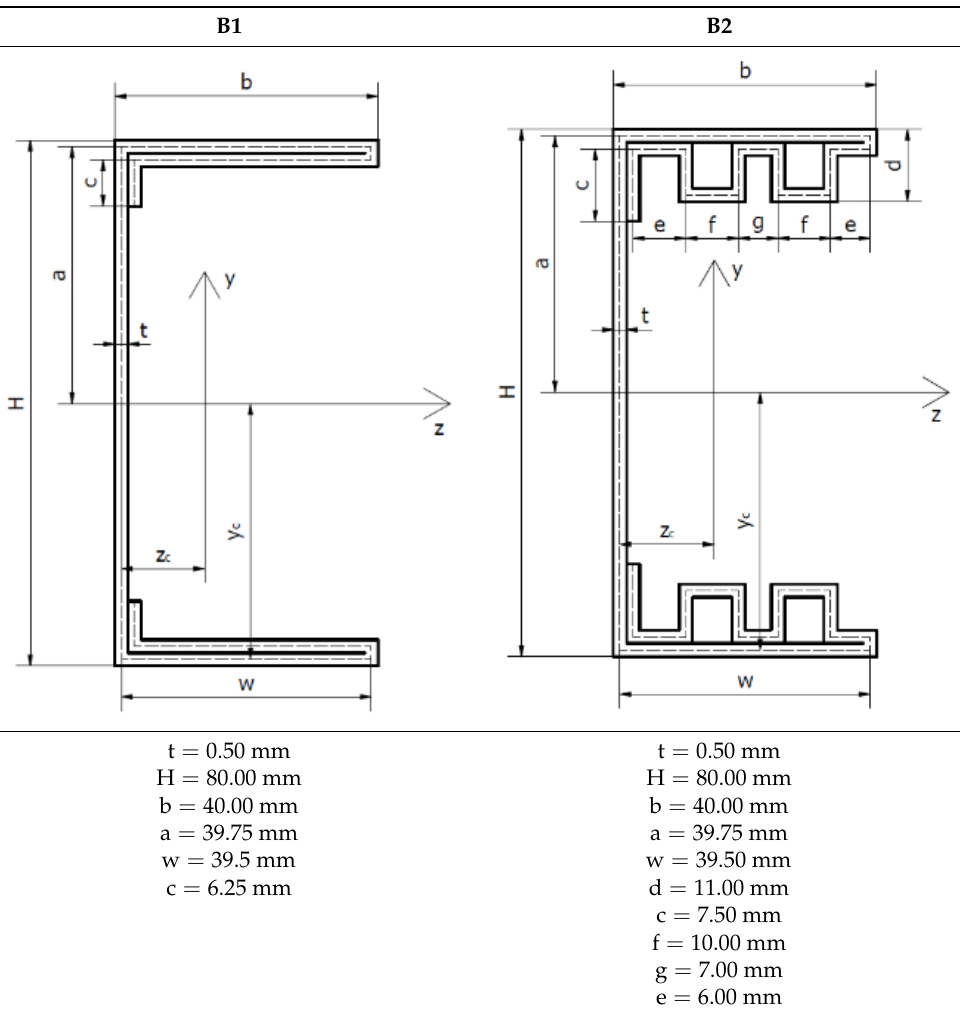
Table 2. Cross-sectional dimensions of tested columns.